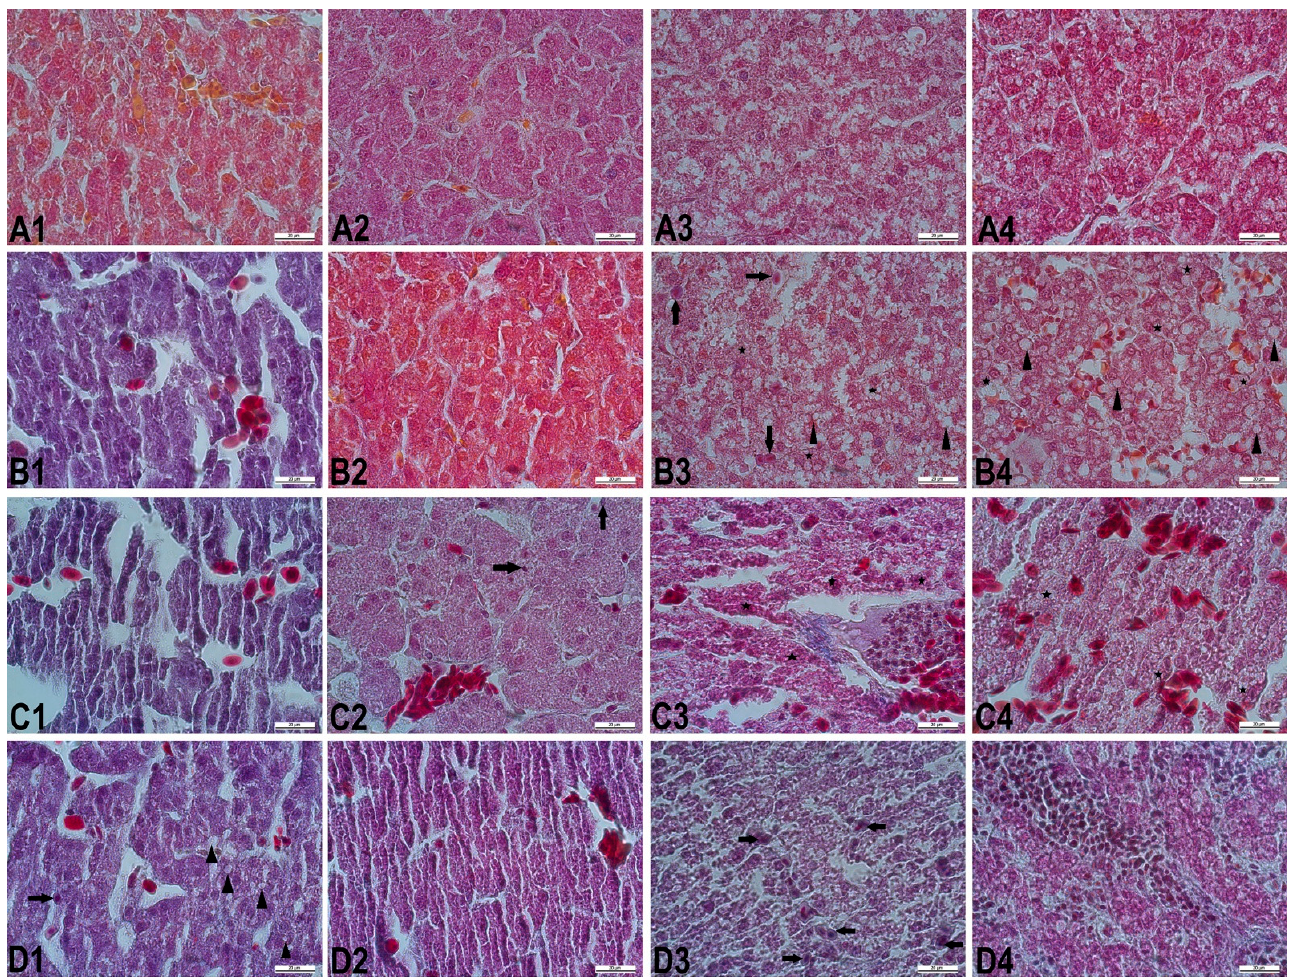
Figure 1. The liver sections in different embryonic periods. ( A1 – A4 ): Normal histological structure in the control group. ( B1 – B4 ): The liver sections from chick embryos treated with SY 200 . ( B1 ): Slightly disorganized hepatic cords, dilatation, and congestion in hepatic sinusoids (day 10). ( B2 ): Slightly irregular hepatic cords (day 13). ( B3 ): A few Kupffer cells (arrows), disorganized hepatic cords, marked hidropic degeneration (stars) in hepatocytes, and mildly vacuolar degeneration (arrowheads) with small droplets (day 16). ( B4 ): Moderately dilatation and congestion in hepatic sinusoids, and marked vacuolar degeneration (arrowheads) with small and large droplets, and hidropic degeneration (stars) in hepatocytes (day 21). ( C1 – C4 ): The liver sections from chick embryos treated with SY 1000 . ( C1 ): Severe disorganized hepatic cords, dilatation in hepatic sinusoids and central vein, and hyperemia (day 10). ( C2 ): Dilated central vein with erythrocytes, and some hepatocytes having pkynotic nuclei (arrows) (day 13). ( C3 ): Diffuse disorganized hepatic cords, Kupffer cells, marked hyaline degeneration (stars) in hepatocytes, and massive infiltration of mononuclear cells in portal vein (day 16). ( C4 ): Severe congestion in hepatic sinusoids and blood vessels, hepatocytes having irregularly shaped nuclei, and diffuse marked hidropic degeneration (stars) (day 21). ( D1 – D4 ): The liver sections from chick embryos treated with SY 2000 . ( D1 ): Kupffer cell (arrow), slightly vacuolar degeneration (arrowheads) with small and large droplets, sinusoidal extensions, slightly impaired hepatic cords (day 10). ( D2 ): Dilated central vein with erythrocytes, and diffuse hyaline degeneration in hepatocytes (day 13). ( D3 ): Kupffer cells (arrows), necrosis of most hepatocytes, hepatocytes having irregularly shaped nuclei (day 16). ( D4 ): Severe marked hyaline degeneration in hepatocytes, massive infiltration of inflammatory cells in portal region, and necrotic foci (day 21). Crossmon’s trichrome staining. Bar = 20 µ